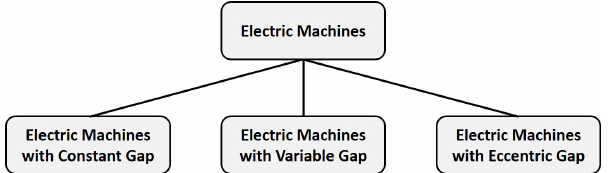
Figure 1. Flowchart showing the electric machines